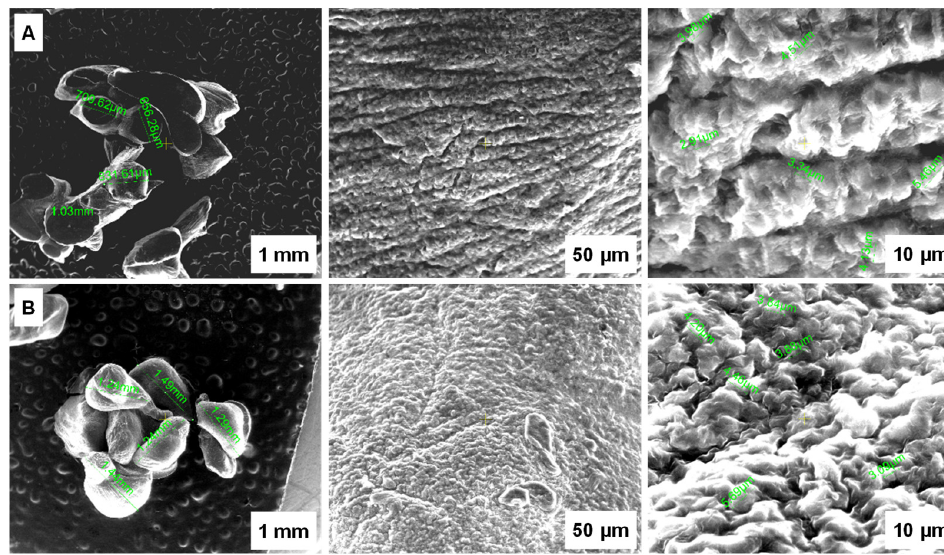
Figure 3. SEM images of the synthesized biosorbent before adsorption ( A ) and after adsorption ( B ) of ethacridine lactate from aqueous solution.